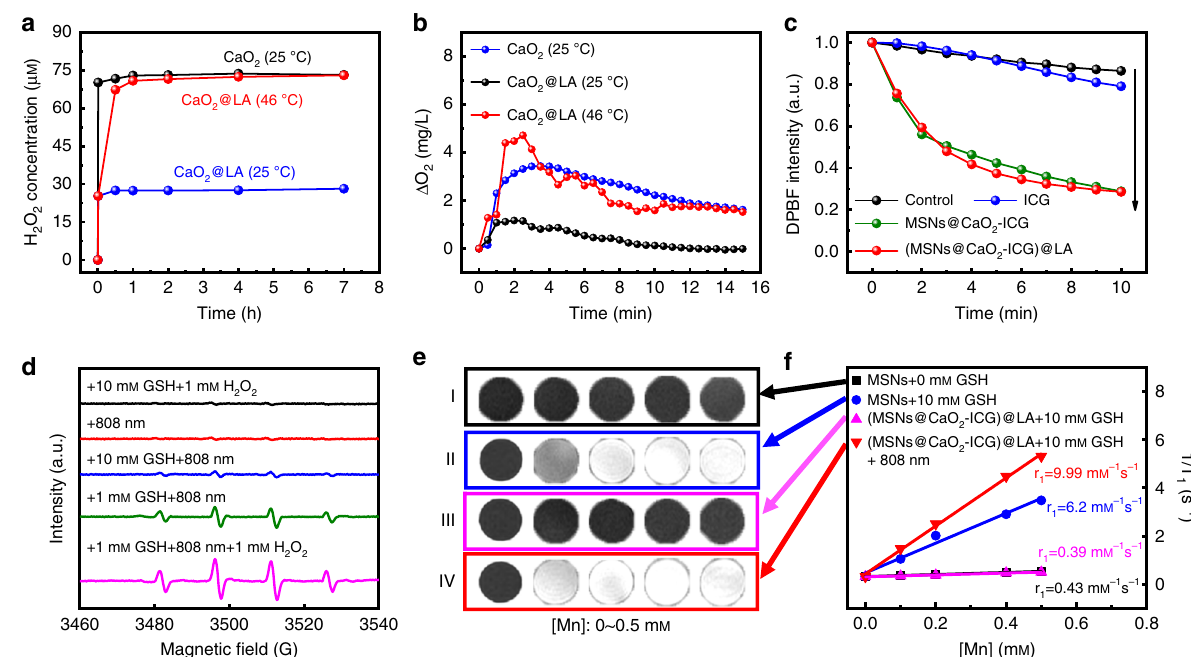
Fig. 3 ROS generation and in vitro MRI. a H 2 O 2 cumulative release pro fi le ([CaO 2 ] = 10 μ g mL − 1 ) and b O 2 concentration measurement in PBS (10 m M , pH = 7.4) ([CaO 2 ] = 100 μ g mL − 1 ). c Time-dependent degradation of DPBF irradiated by laser for 10 min. ([MSNs] = 50 μ g mL − 1 , [ICG] = 8 μ g mL − 1 . Laser: 808 nm, 0.64 W cm − 2 ). d EPR analysis of (cid:129) OH production in each group with different treatment. DMPO was used as the spin-trapping agent. The sample in each group was (MSNs@CaO 2 -ICG)@LA aqueous solution ([MSNs] = 50 μ g mL − 1 ). e In vitro MRI of different solution and f the